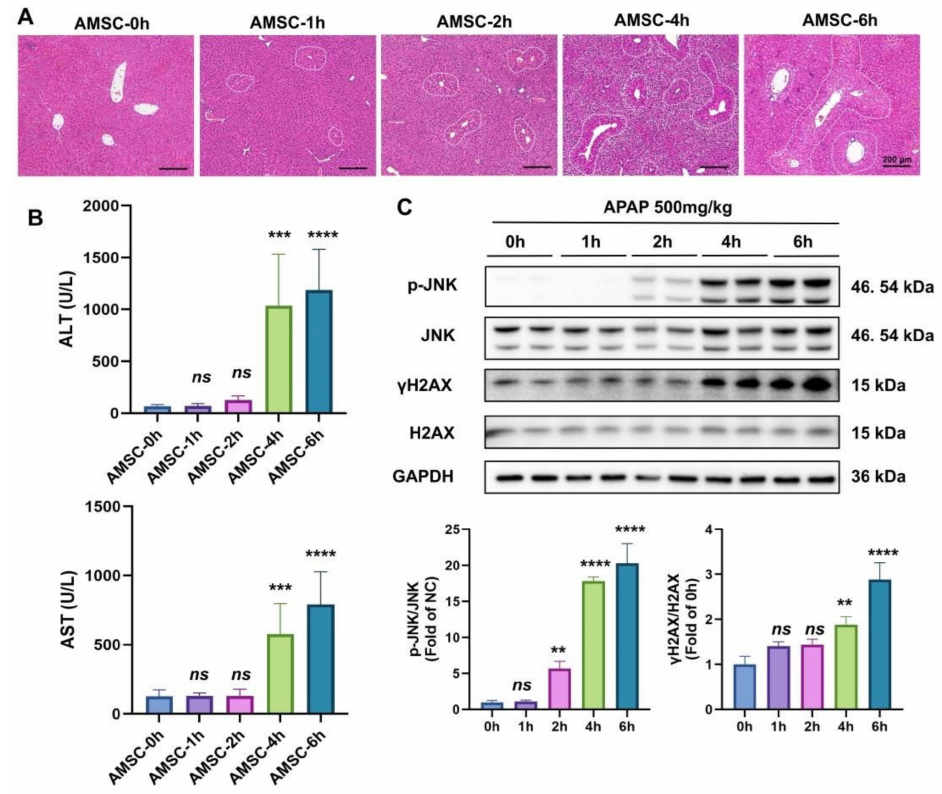
Figure 3. The APAP-induced mitochondrial retrograde pathway limits therapeutic potential of AMSCs. ( A ) Representative HE-staining of delayed AMSCs injection at 1 h, 2 h, 4 h, and 6 h after APAP exposure. ( B ) Serum ALT and AST. ( C ) The protein expression levels of p-JNK and γ H2AX at different times after the APAP challenge. Data are presented as the mean ± SD; n = 3–5; ** p < 0.01, *** p < 0.001, **** p < 0.0001 and ns: no significance vs. 0 h